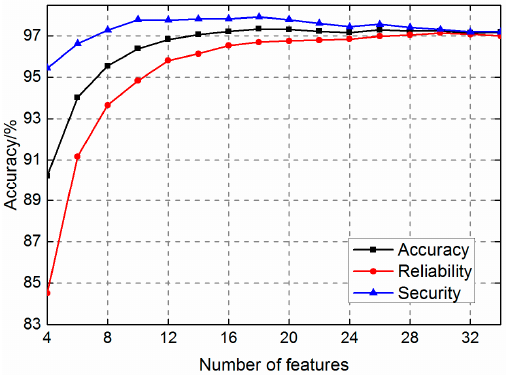
Figure 14. Prediction results of SVM ‐ based ensemble classifiers using different numbers of features.